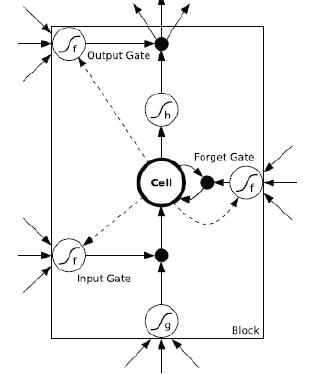
Figure 3. Structure of LSTM memory